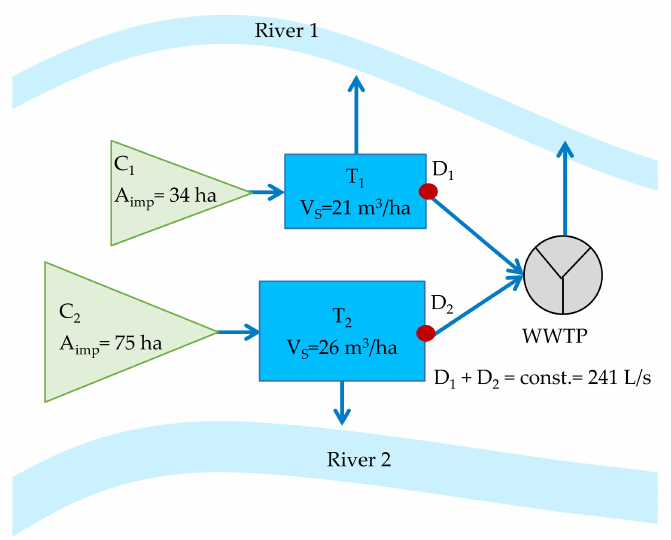
Figure 2. Conceptual catchment for measured data-based system optimization; C = catchment, D = controlled outflow, WWTP = wastewater treatment plant; T = combined sewer overflow tank, V S = specific storage volume, A imp = impervious